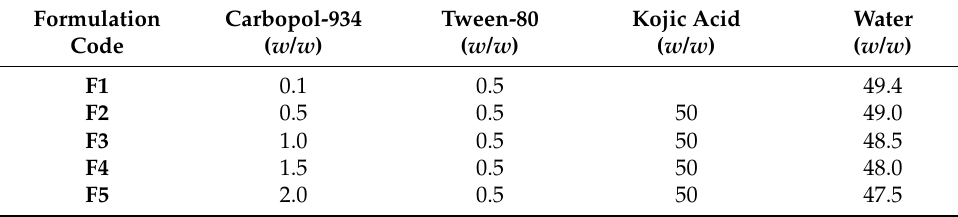
Table 1. Various compositions of KA